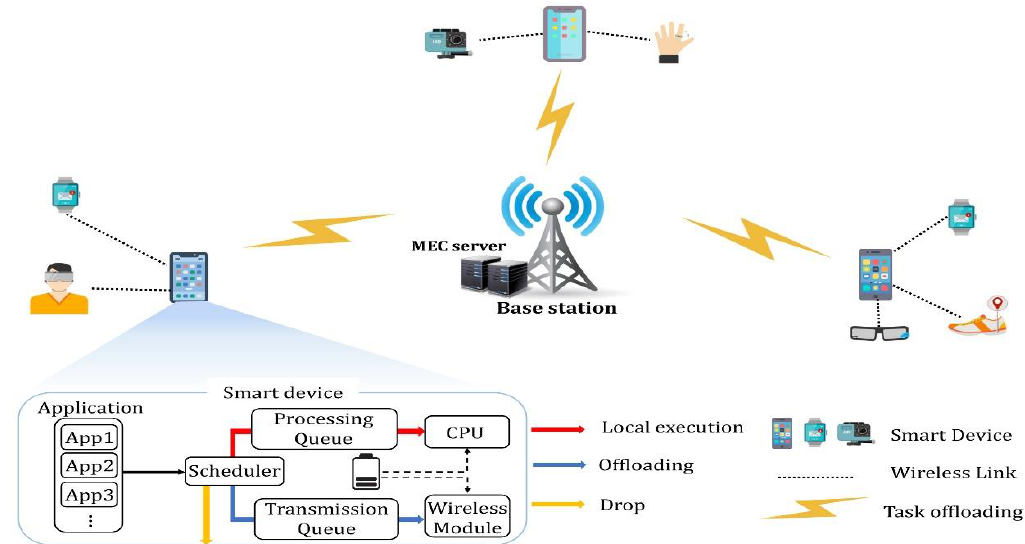
Figure 3. Scenario of the MEC system Model.